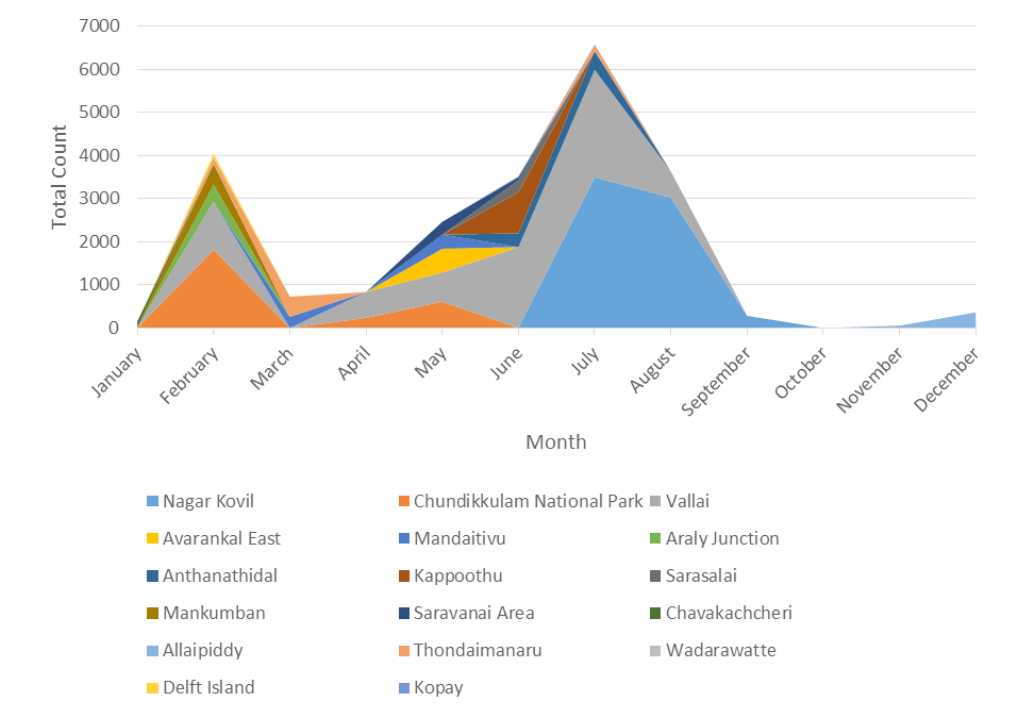
Figure 4: Monthly variation in the number of greater flamingo at each study site.